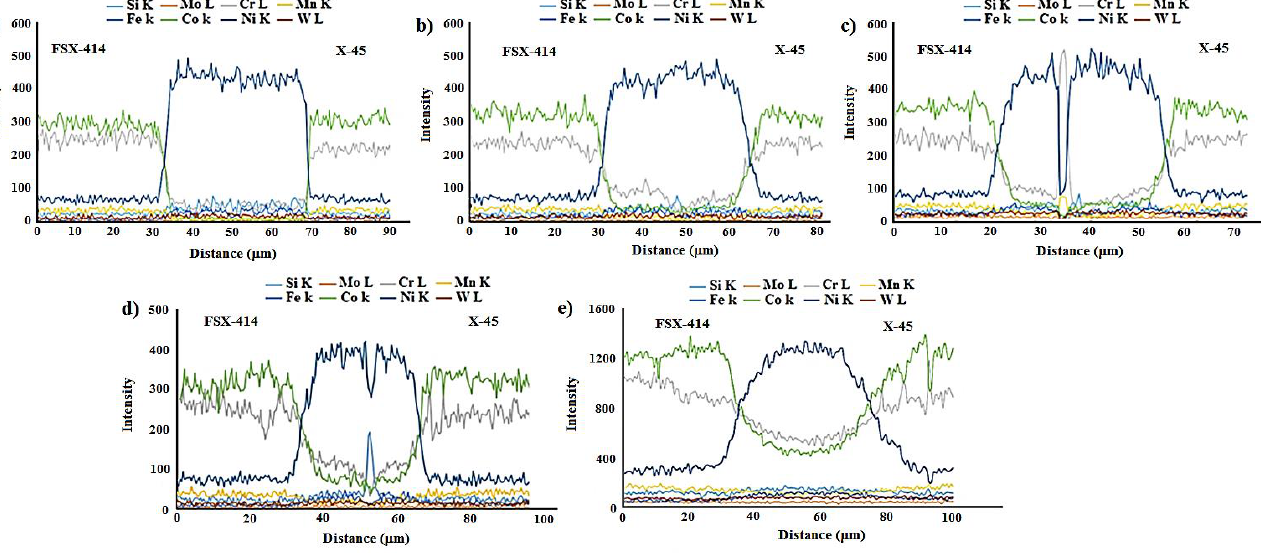
Figure 8. The SEM microstructure of the TLP-bonded specimen at a constant holding time 10 min and different temperatures: ( a ) 1010 °C (A-B Line Scan), ( b ) 1050 °C (C-D and E-F Line Scan), ( c ) 1100 °C (G-H Line Scan), and ( d ) 1150 °C (I-J Line Scan).